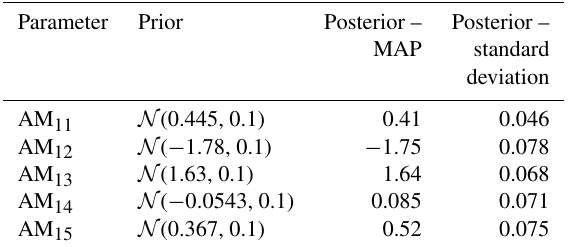
Table 3. Summary of prior and posterior distribution for New MEXICO yaw model